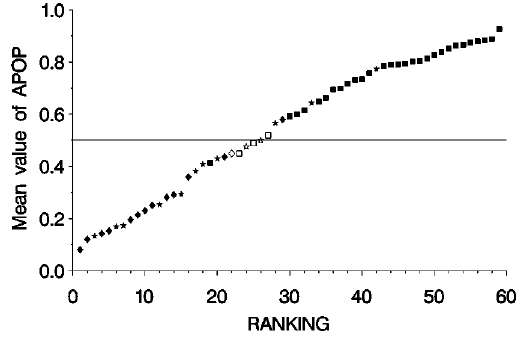
Fig. 4. Specimen classification results of TC and SCLC using WD- NEC as a test set ( (cid:7) TC cases, (cid:4) SCLC cases, ? WDNEC cases, open symbols: unclear decisions).